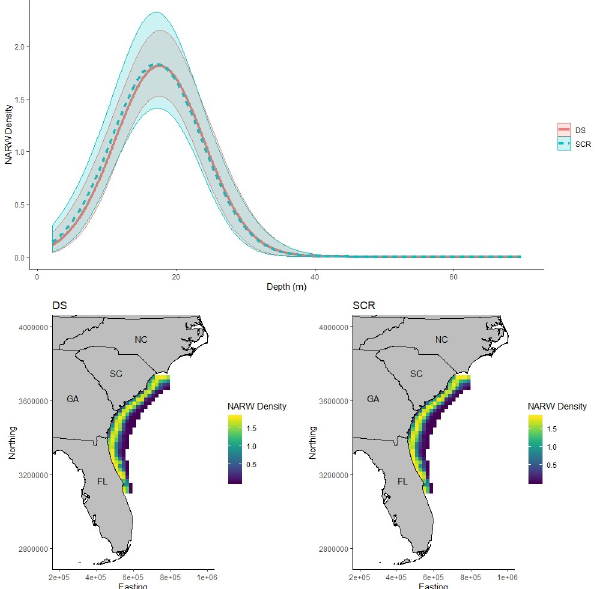
Fig 2. North Atlantic right whale density. Expected North Atlantic right whale (NARW) density per 400 km 2 . NARW density was estimated as a quadratic function of depth within the state space using distance sampling (DS; bottom left panel and red in top panel) and spatial capture-recapture (SCR; bottom right panel and blue in top panel). Posterior mean expected density and 95% credible intervals across the range of depth in the state space is illustrated in the top panel for both DS (red) and SCR (blue) models. Bottom panels illustrate posterior mean expected density across the state space for DS (left) and SCR (right) models that included depth and depth 2 as covariates on density.